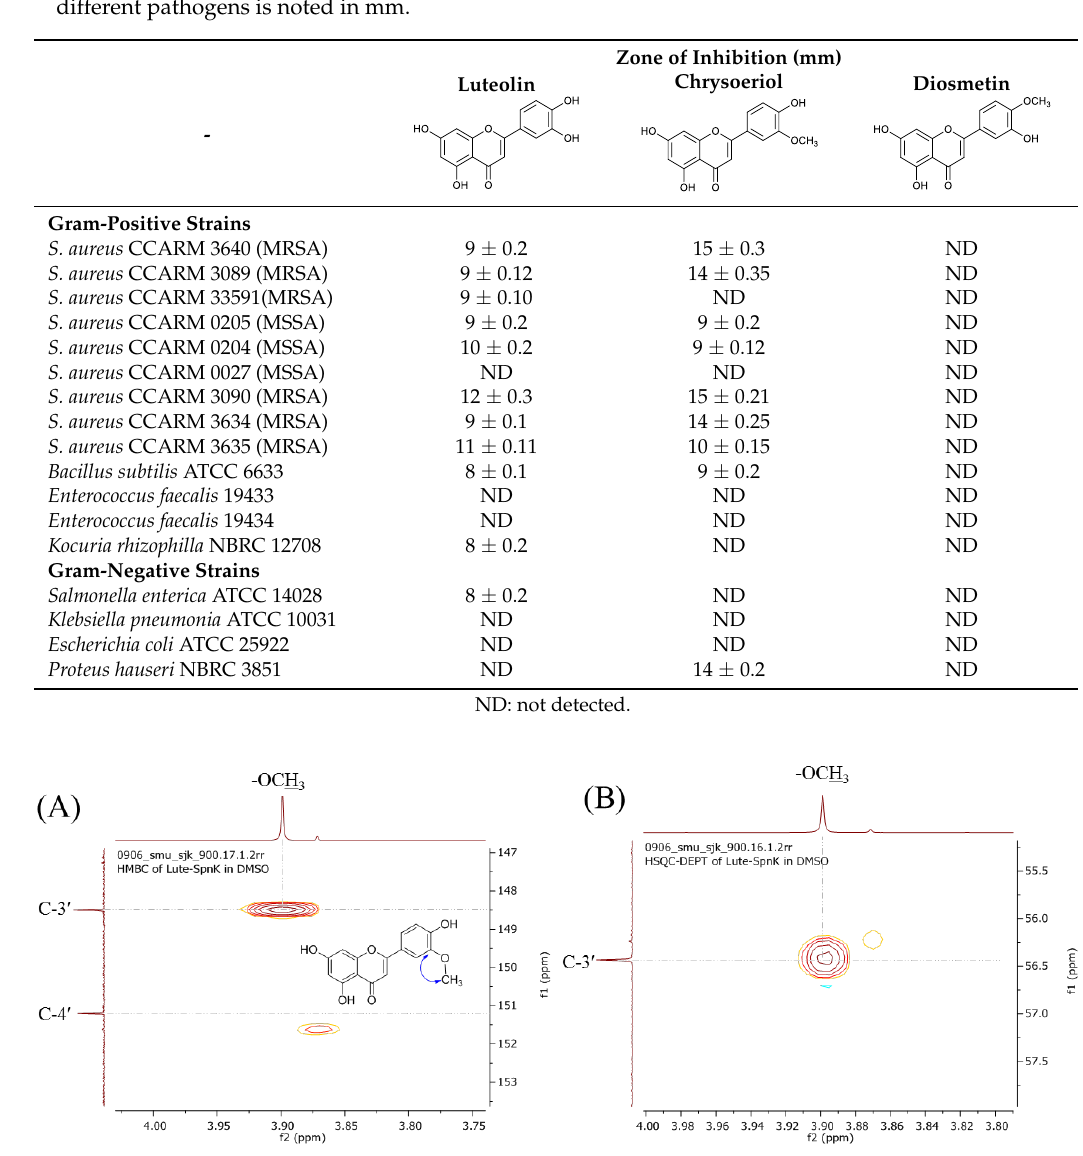
Figure 4. Zoomed-in view of ( A ) HMBC and ( B ) HSQC-DEPT analyses of chrysoeriol. The cross